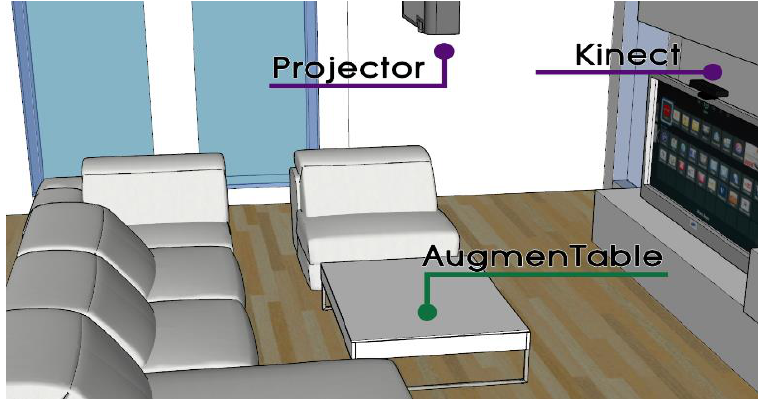
Figure 3. AugmenTable consists of a projector embedded on the ceiling above the coffee table, and a Kinect sensor installed on top of the TV.